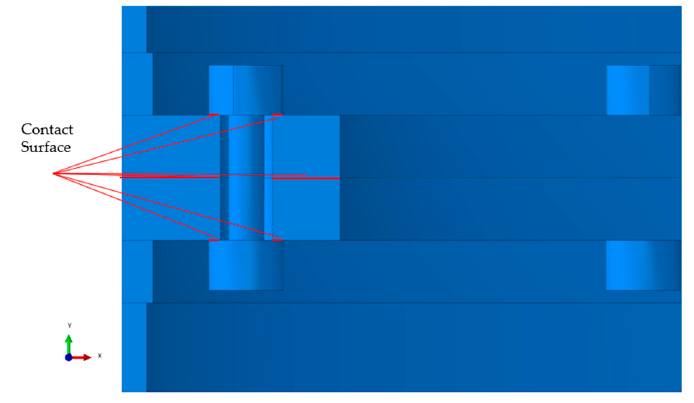
Figure 6. Contact surface of the connection structure.